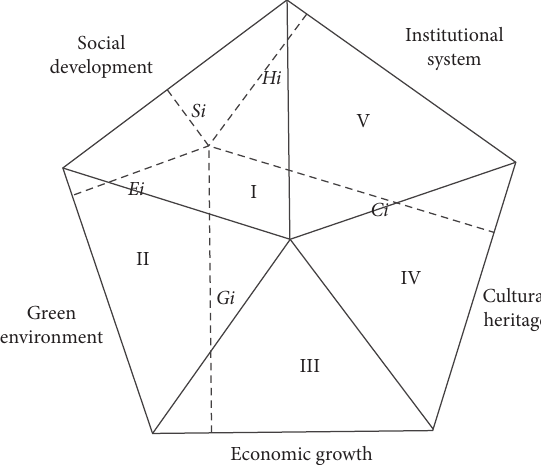
Figure 1: Schematic diagram of the pentagon model of the system of society, environment, economy, culture, and institution.